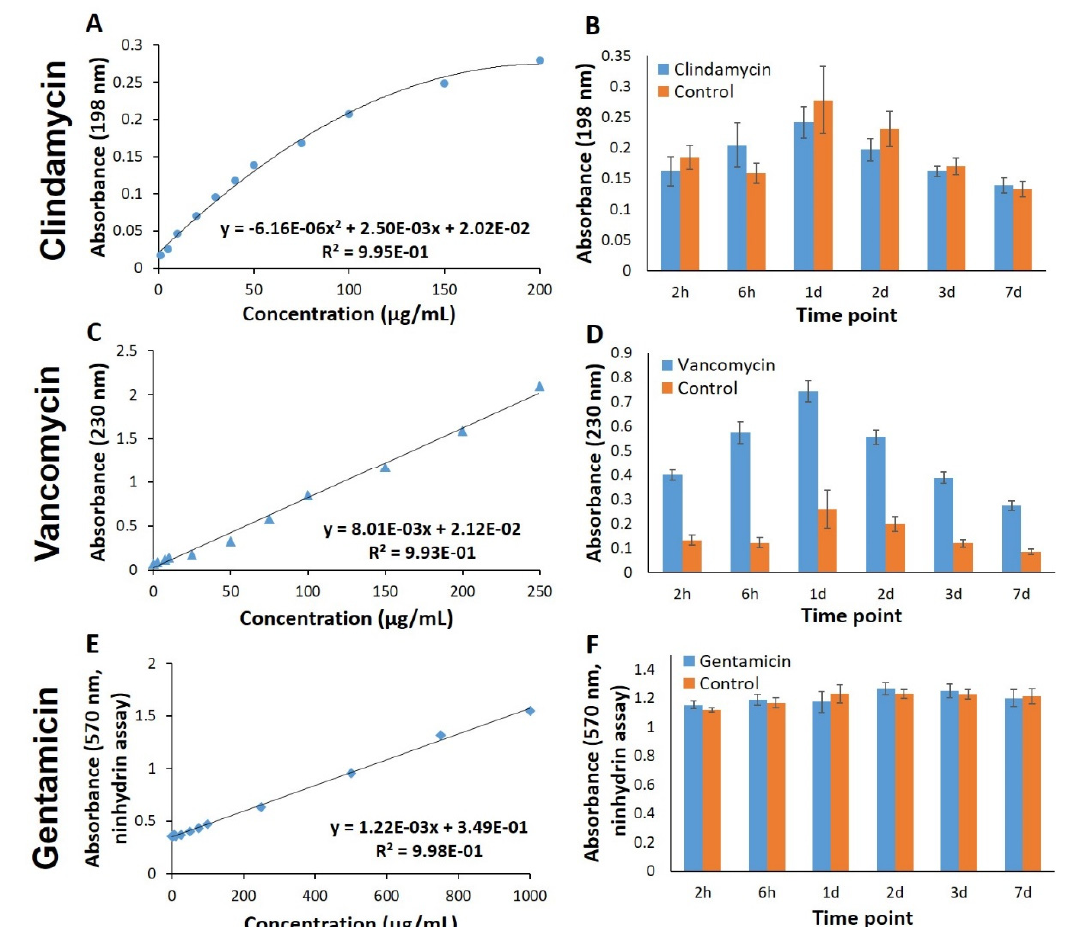
Figure 4. Spectrophotometric quantification of antibiotics. Standard curves ( A , C , E ) obtained by measuring the absorbance at 198 nm, 230 nm and Ninhydrin assay of defined concentrations of clindamycin, vancomycin and gentamicin in 0.9% NaCl solution, respectively. Analysis of the release solutions ( B , D , F ) obtained from antibiotic loaded and unloaded (control) ALG-MC scaffolds, using the respective method ( n = 5).